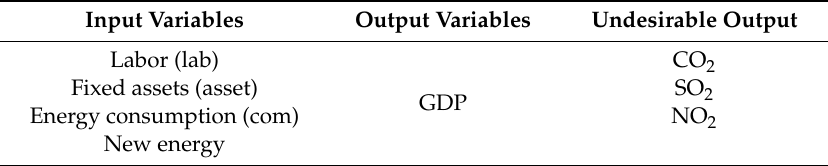
Table 1. Input and output variables. GDP—gross domestic